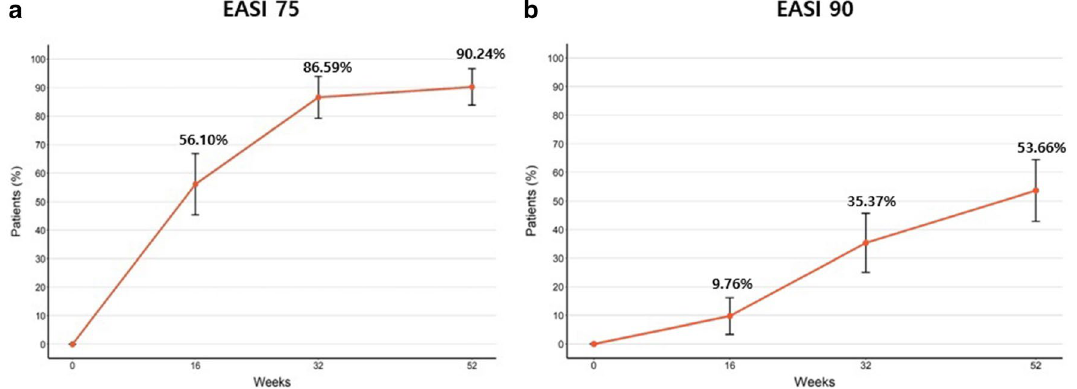
Figure 1. The proportion of ( a ) EASI 75 and ( b ) EASI 90 at baseline, after 16, 32 and 52 weeks.